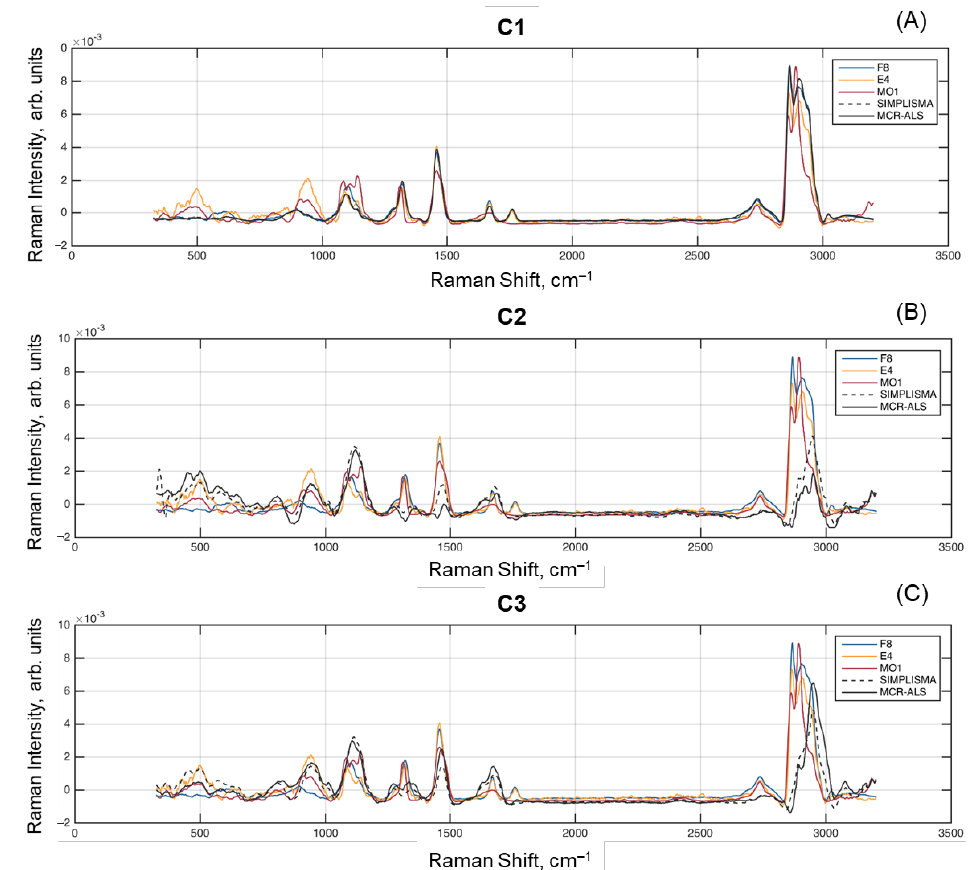
Figure 7. Comparison of spectra resolved by multivariate curve resolution methods and measured reference spectra: ( A ) Component 1; ( B ) Component 2; ( C ) Component 3.